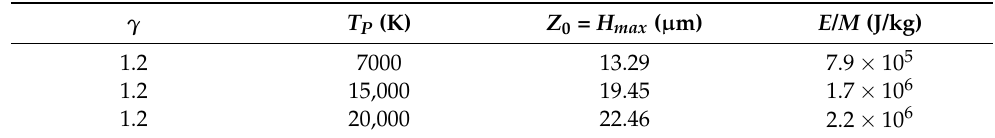
Table 3. Plasma plume parameters used in the